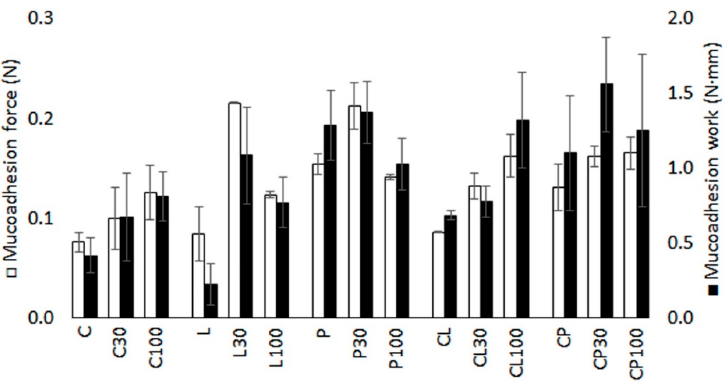
Table 4. Results of the ANOVA processing of the mucoadhesion forces of the batches; the factors are the nature of the polymer and the drug content. p -values below α = 0.05 indicate no significant differences.